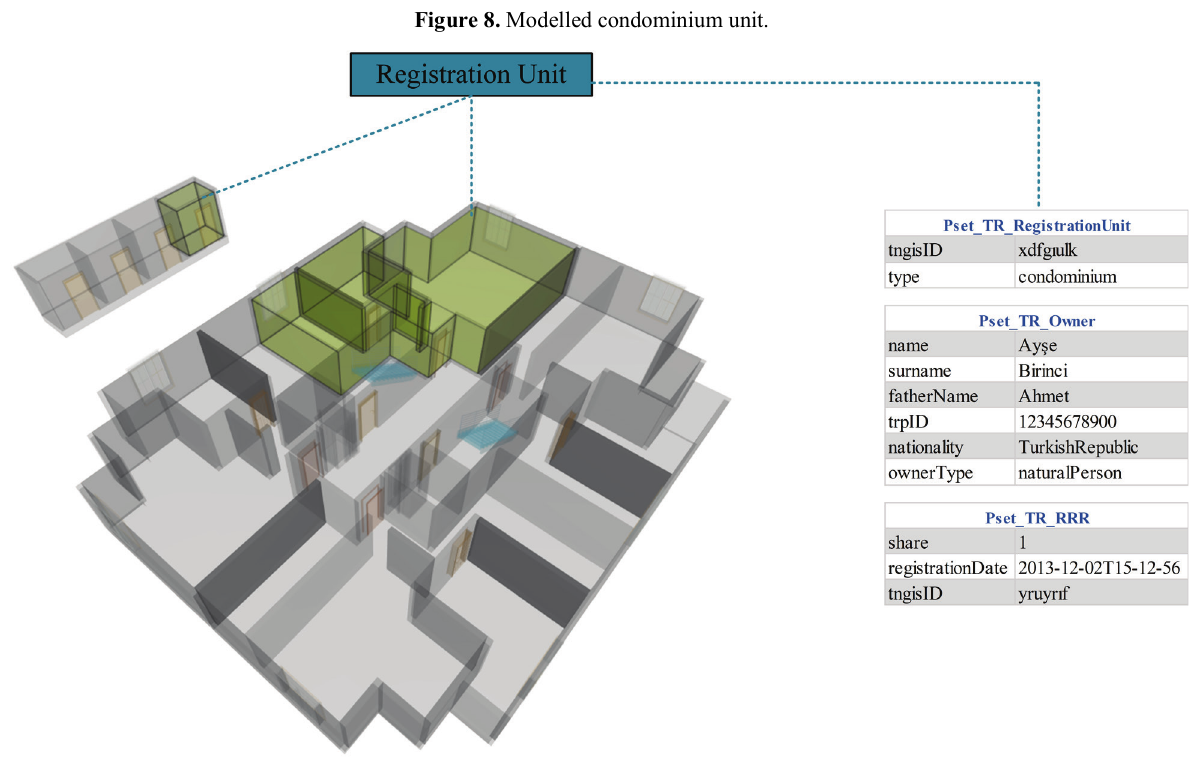
Figure 9. Modelled registration